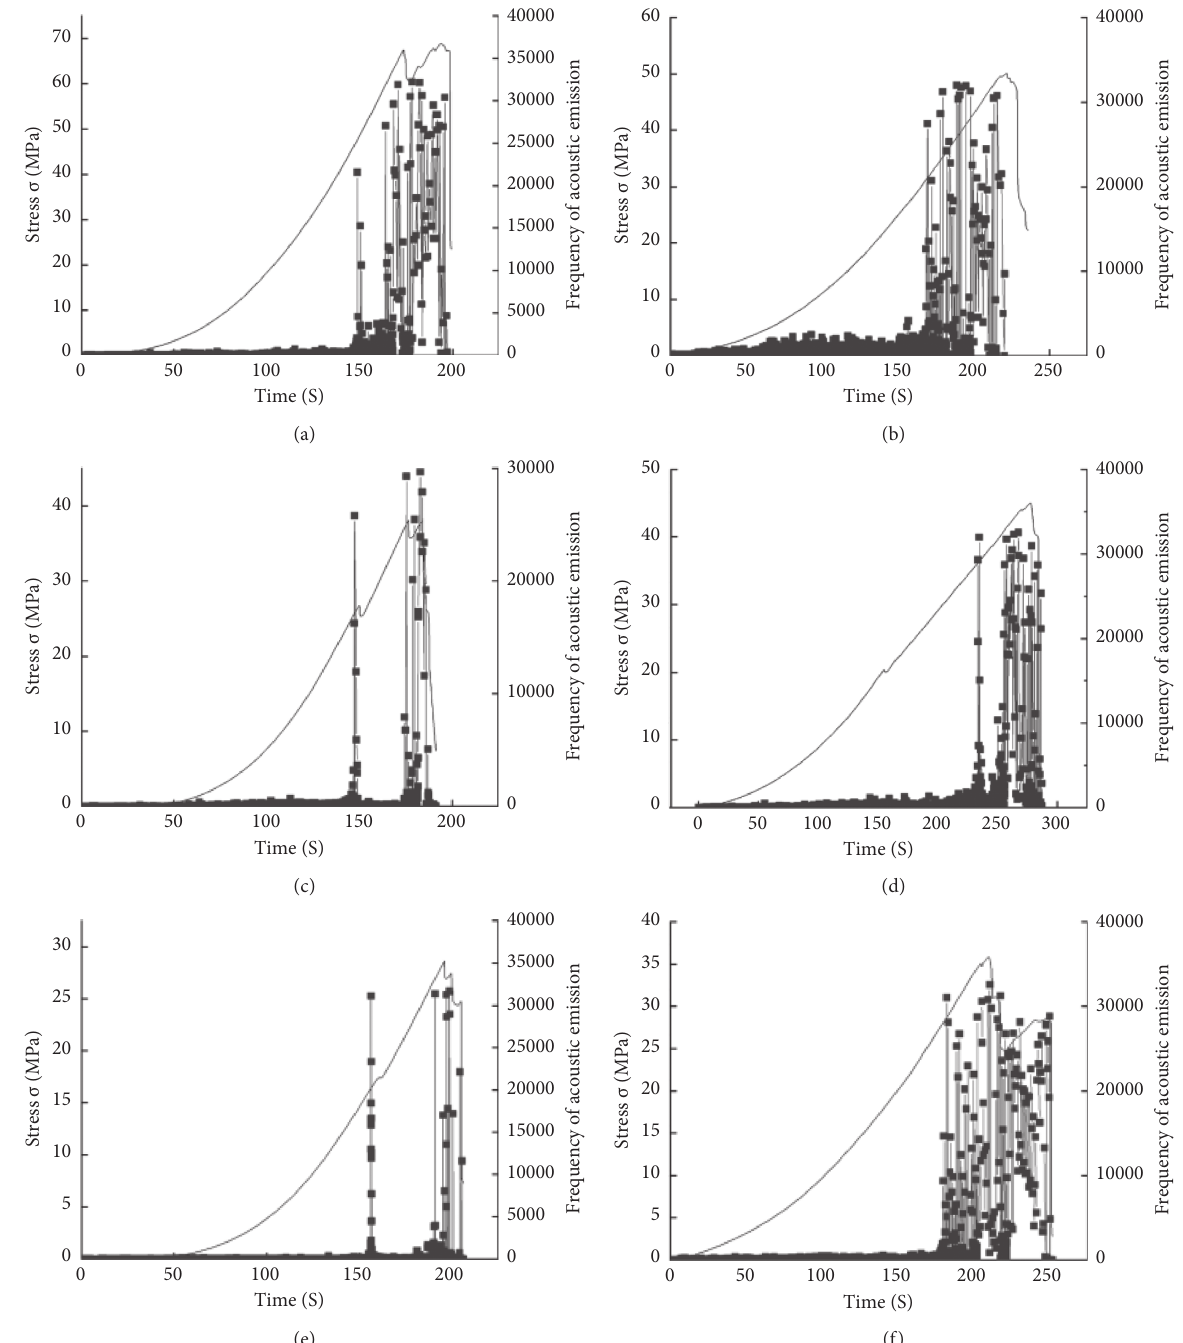
Figure 11: Stress-time-acoustic emission information of the rock sample with different hole positions. (a) Stress- N -time of rock B05. (b) Stress- N -time of rock E05. (c) Stress- N -time of rock C10. (d) Stress- N -time of rock F10. (e) Stress- N -time of rock D15. (f) Stress- N -time of rock